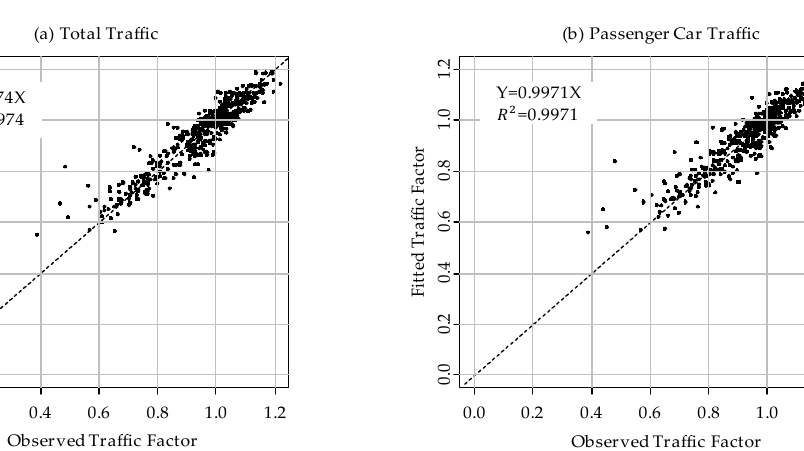
Figure 6. Fitted dummy variable regression modeling results at Leduc Highway 2A.